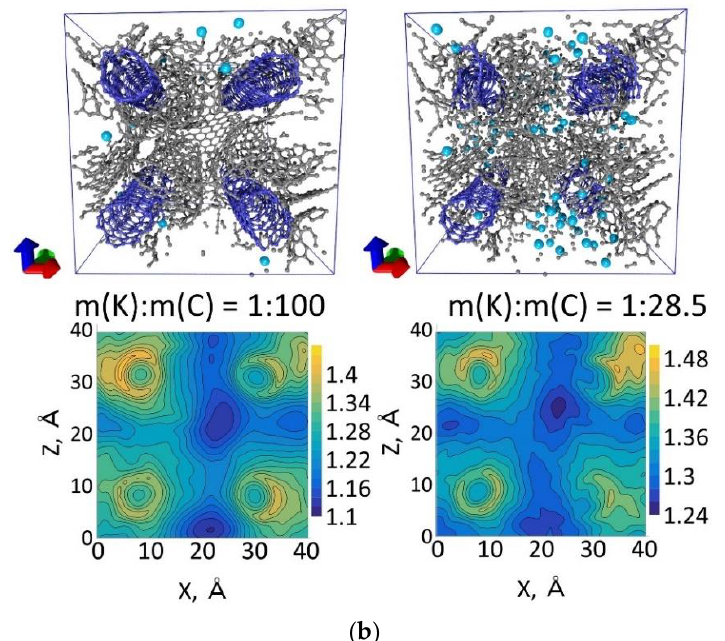
Figure 2. Supercells and maps of the local density distribution of GLC reinforced with (4,4) ( a ) and (6,5) SWCNTs ( b ) when filled with potassium at a mass ratio of potassium/carbon (m(K):m(C)) of 1:100 and 1:14.